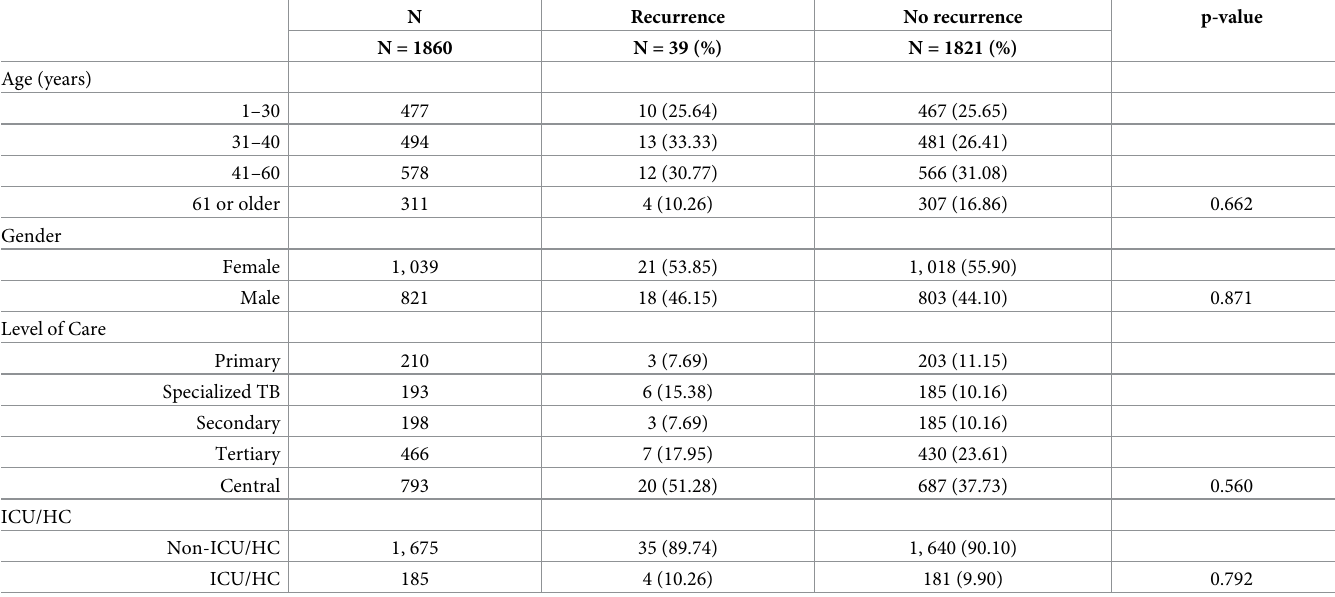
Table 5. Univariate analysis of factors associated with CDI